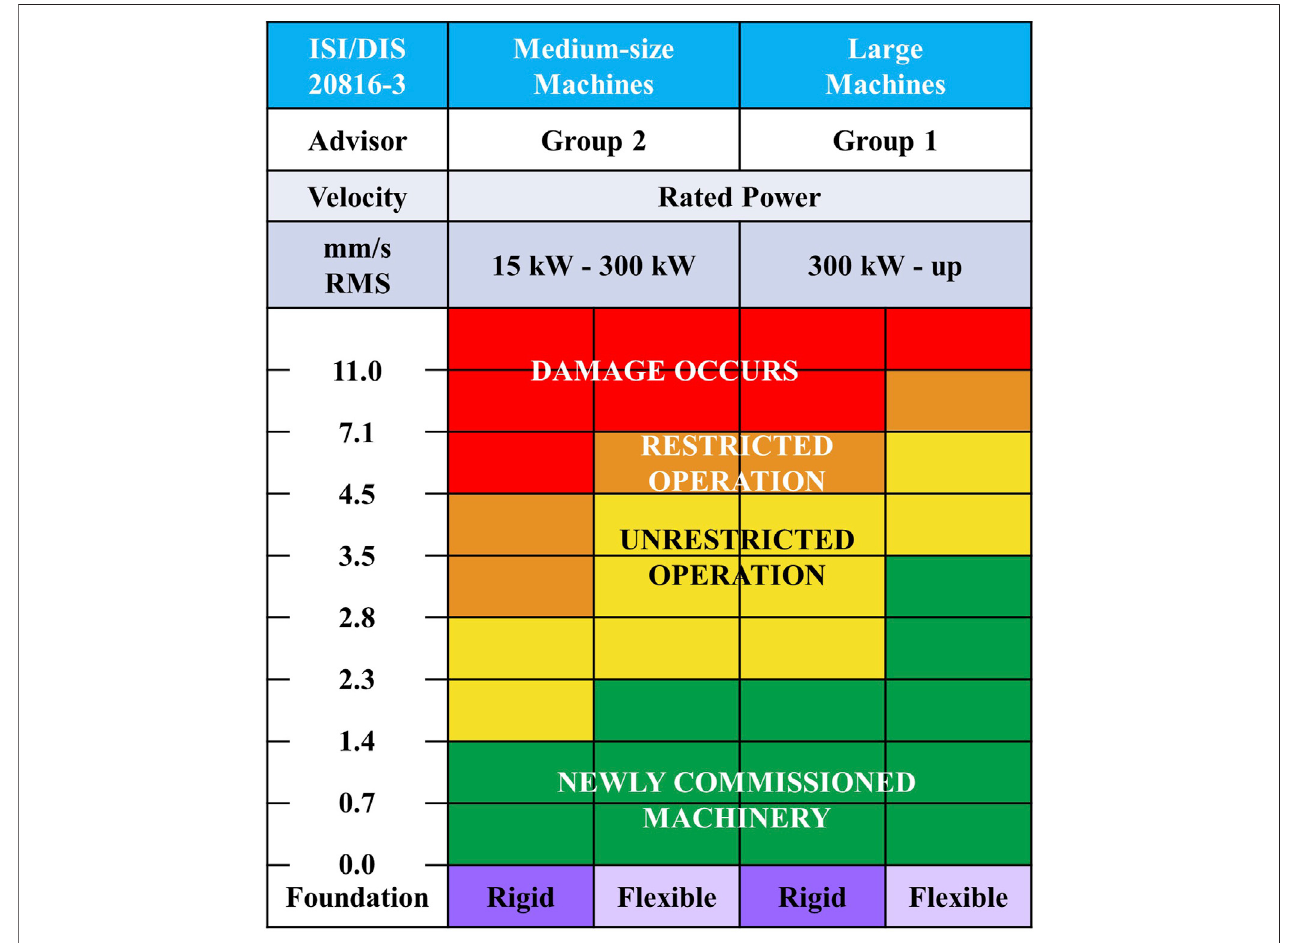
FIGURE 2 | ISO/DIS 20816 – 3 Guidelines for vibration